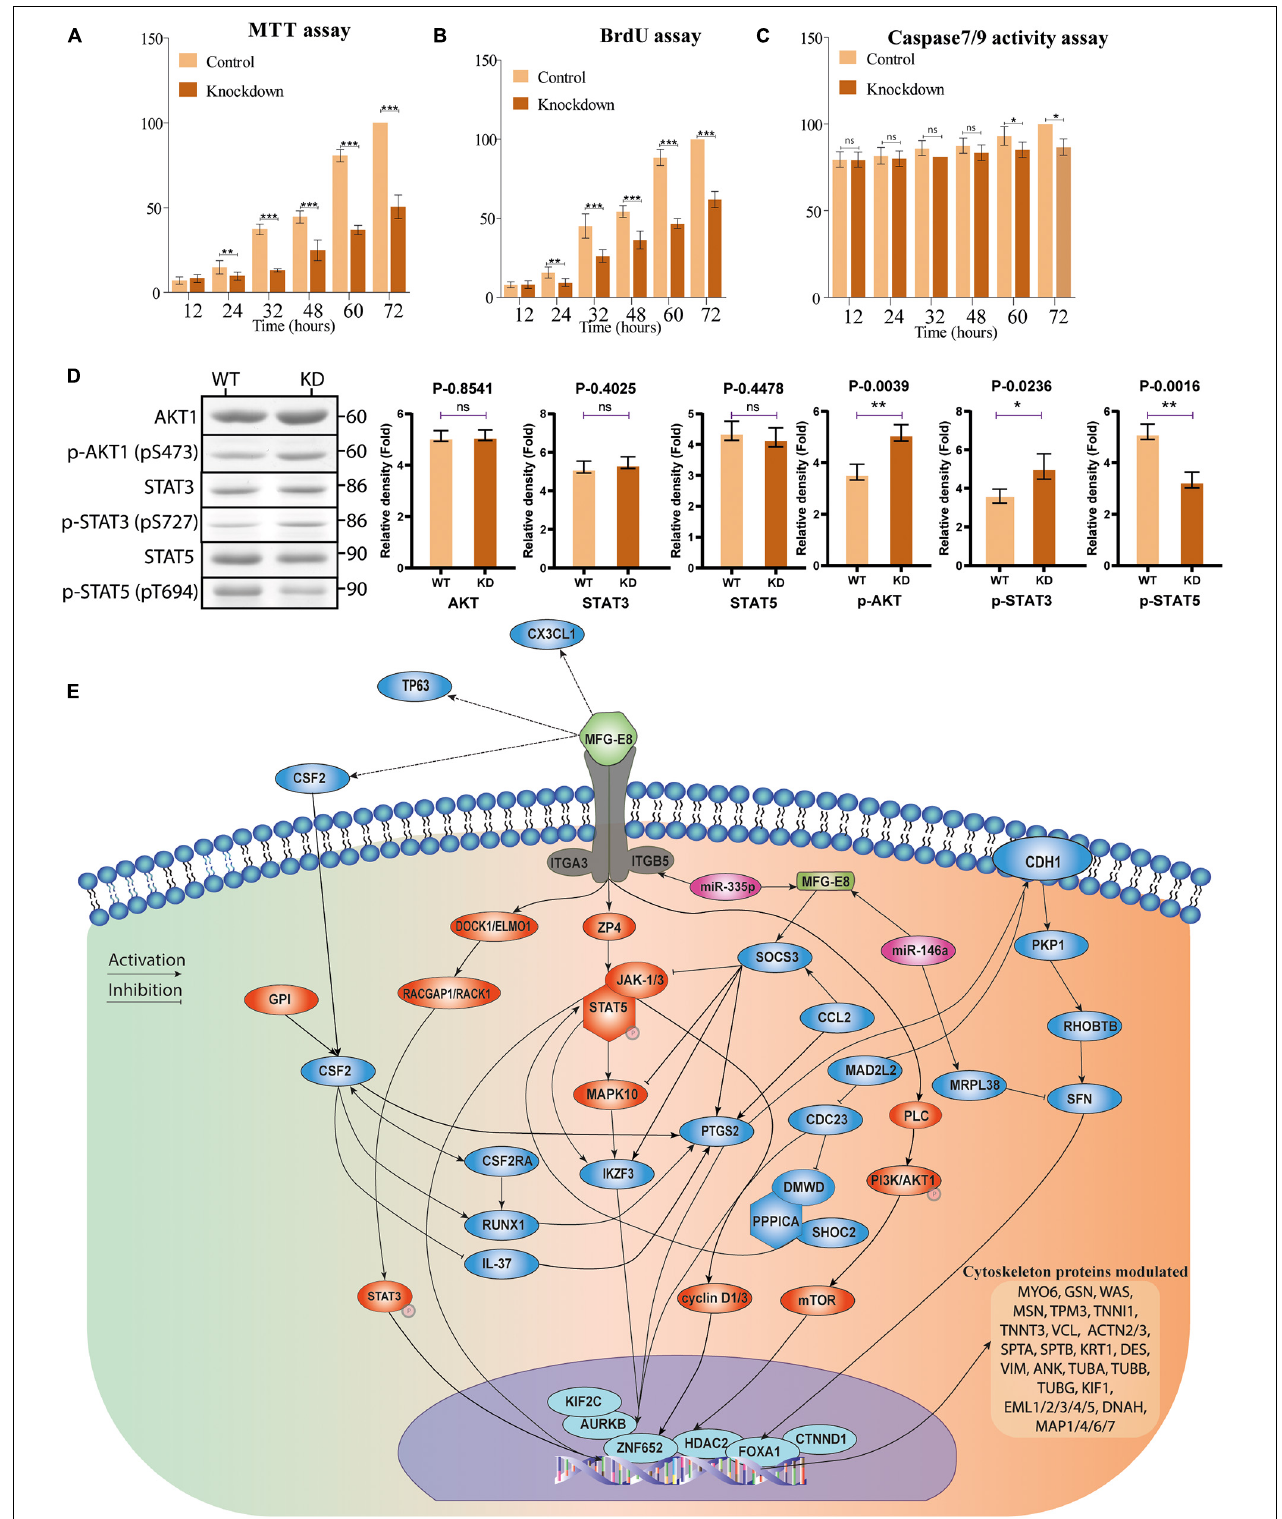
FIGURE 8 | Multiple assays for validation. (A) MTT assay. The cell proliferation MTT assay for the control and MFG-E8 KD BuMEC cells were performed. All experiments were performed six times points at 12-h intervals up to 72 h of culture. The values were calculated using a non-parametric t -test, and the error bar is